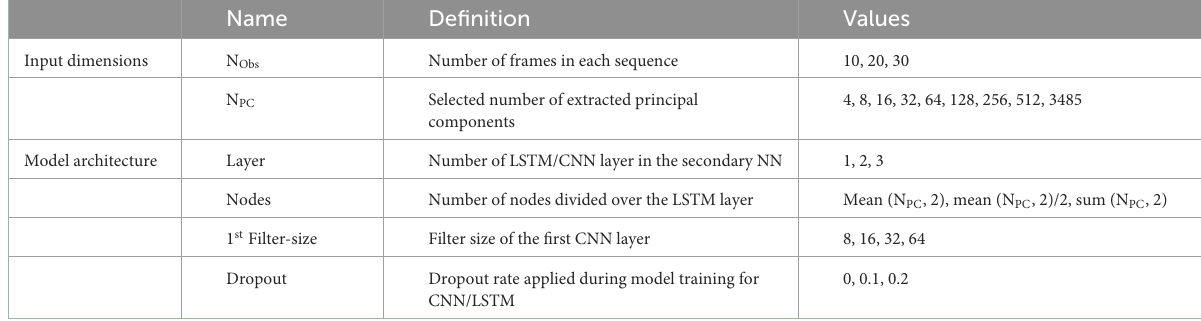
TABLE 3 Parameter specifications, which were compared by the